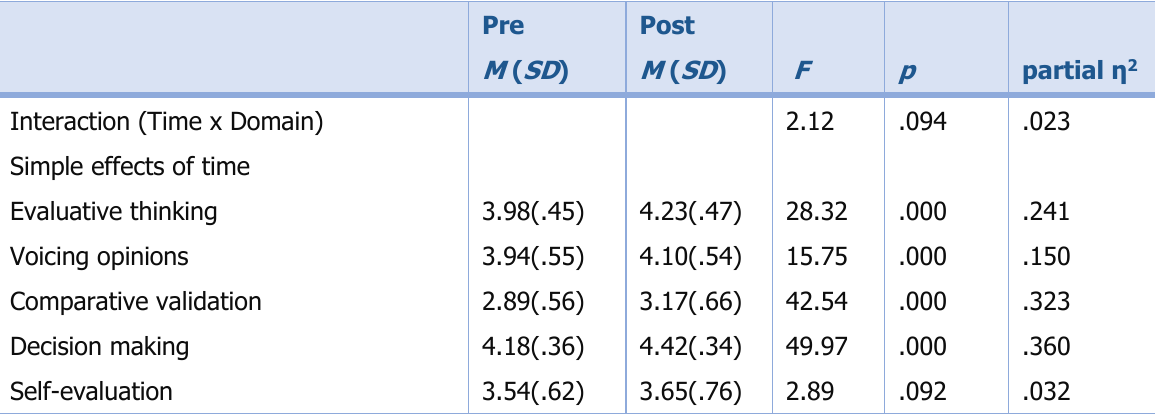
Table 3. Two-Way Repeated Measures ANOVA for Cognitive Autonomy